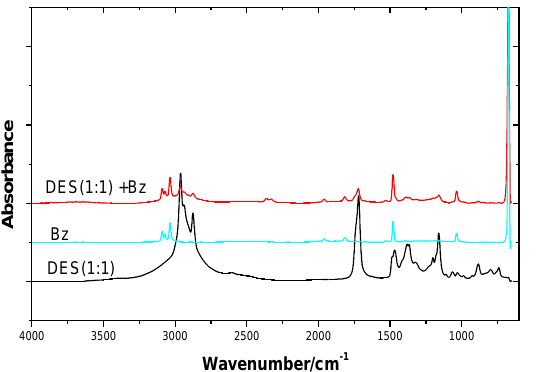
Figure 13. Experimental and calculated data X’Y diagram for cyclohexane (1) + benzene (2) + DES (3) at constant pressure (101.325 kPa) and constant DES molar fraction ( X 3 = 0.2).